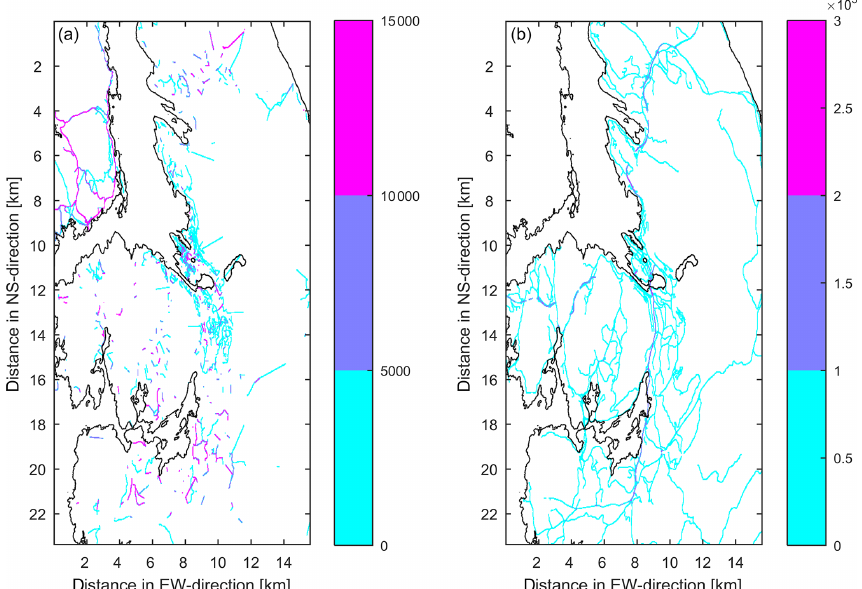
Figure A1. Annual mean daily traffic flow in vehicle metres ( N i × l i ) in each PALM grid cell for side streets (a) and main roads (b) . Both colour shadings have the unit of metres. Roads in the left panel that are appearing to go straight into mountainous areas are sporadically used small utility roads. For simplicity of the underlying traffic model, they are indicated as straight roads instead of following their actual path. Emissions from these roads are negligible.